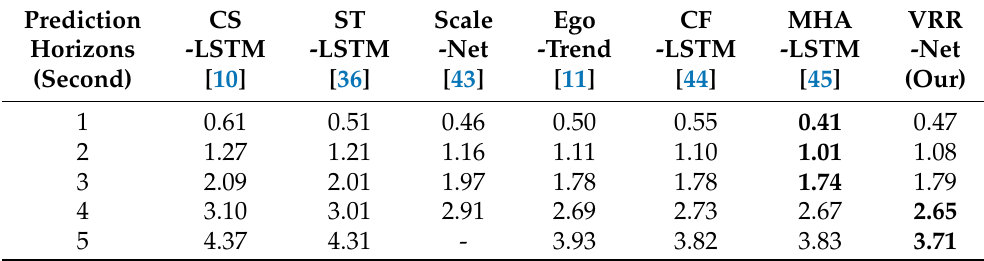
Table 1. The RMSE performance of the proposed model and the existing advanced models are compared on the NGSIM dataset. The best result is marked in black.